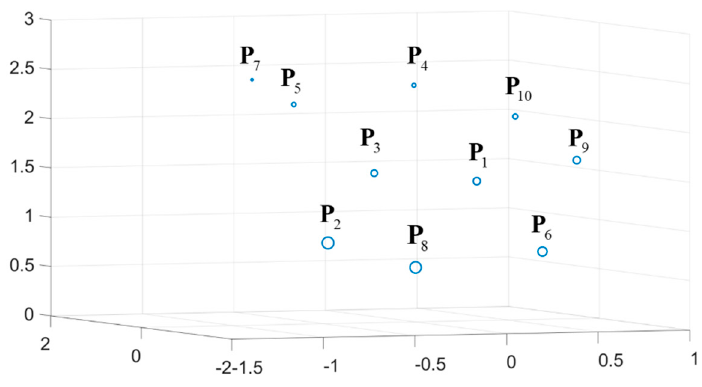
Figure 27. Set of static poses and the positioning error of the moving platform illustrated by the size of each point.